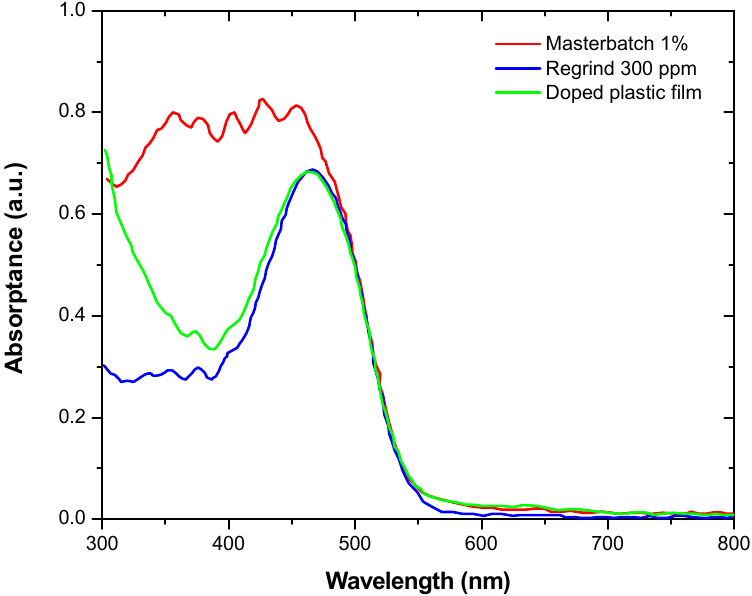
Figure 4. Absorption characterization at different manufacturing stages of the luminescent film. It is shown how the LDS absorption band was degraded after the second extrusion step.